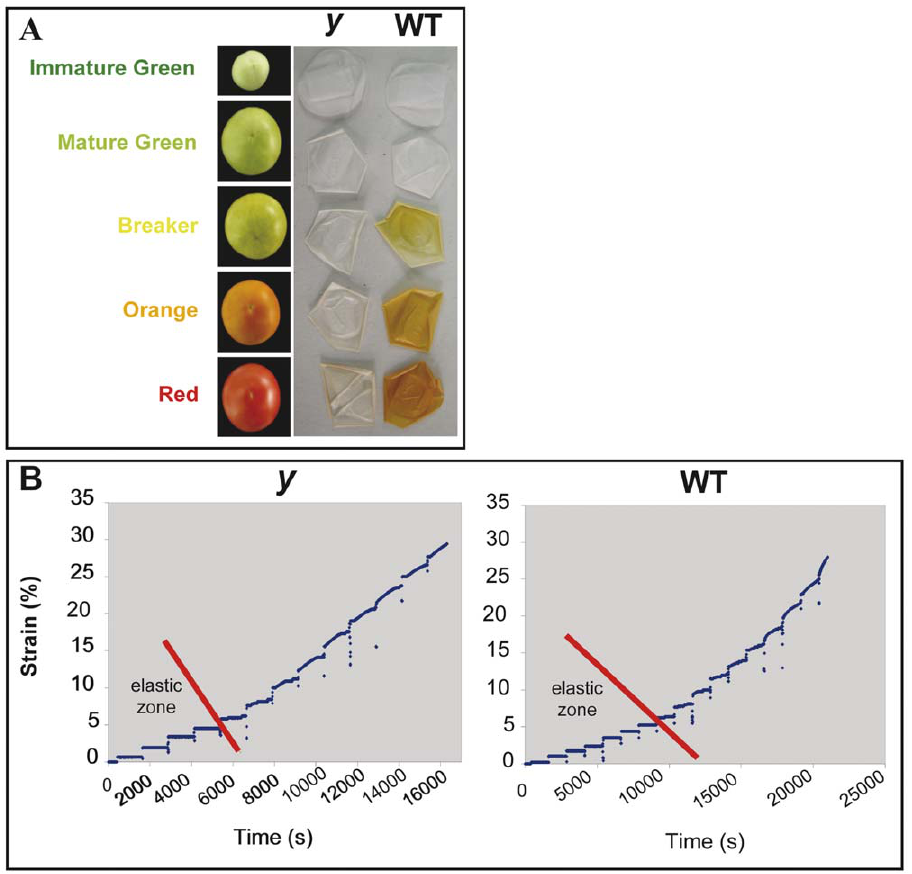
Figure 1. The y mutant phenotype and its cuticular properties. (A) Enzymatically isolated cuticles (n=20) of wt and y mutant at five stages of fruit development. (B) Biomechanical tests of isolated fruit cuticles (n=7) at the red stage of development reveal significant differences in the elastic phase between wt and y mutant cuticles.